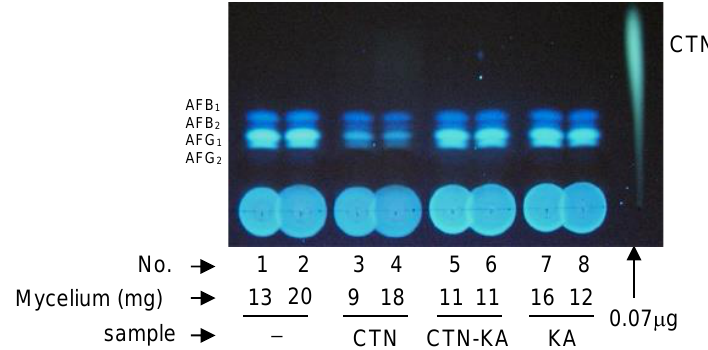
Figure 10. The effects of CTN, the CTN-KA adduct, and KA on the production of AFs in the tip culture. Spore suspension (5 µ L) of A. parasiticus strain SYS-4 was added to 200 µ L YES medium supplemented with CTN, the CTN-KA adduct, or KA, and then cultured for 4 days. For the evaluation of the effect of the adduct, 1.9 mM CTN and 71.4 mM KA were pre-incubated in 50 mM K-phosphate buffer (pH 7.5) at 50 ◦ C for 6 h. The resulting solution (40 µ L) was then added to 160 µ L YES medium in a tip culture, and the spore suspension was added and then cultured. After culture at 28 ◦ C for 4 days, the culture media were analyzed by TLC using developing solution 1. Mycelial weights are also shown. The experiments were done in duplicate.